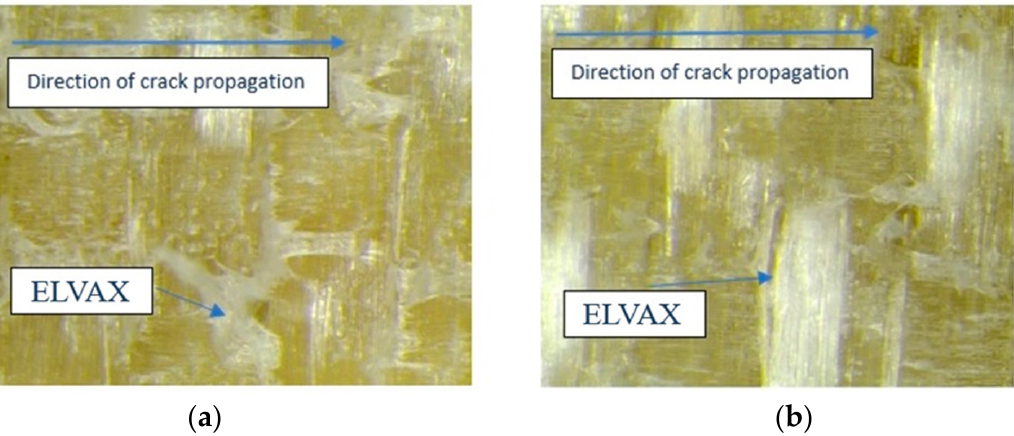
Figure 15. Optical microscopic images of Mode II specimen ( a ) Bottom surface; ( b ) Top surface.